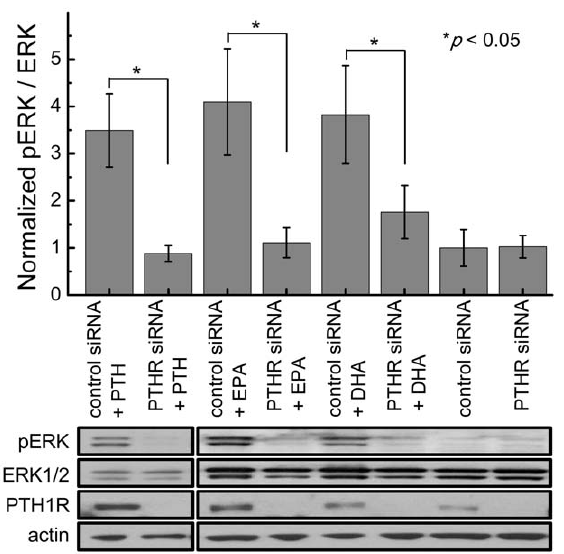
Figure 8. PTH1R siRNA inhibits ERK1/2 response to PTH(1–34) and fatty acids. MC3T3-E1 cells transfected with 100 nM siPTH1R or scambled control siRNA 96 hours prior to treatment with 10 nM PTH(1– 34), 1 m M EPA, or 1 m M DHA. Data represents the mean of at least 8 independent samples.